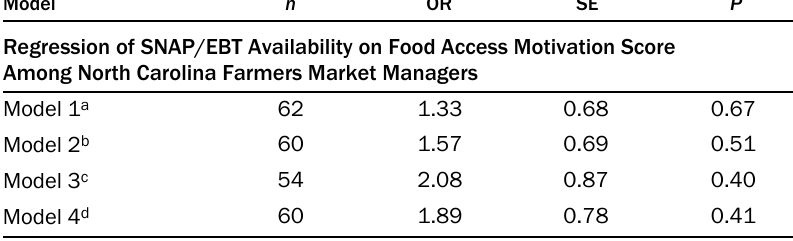
Table 3. Association Between North Carolina Farmers Market Managers’ Food Access and Business Motivation Scores and Supplemental Nutrition Assistance Program Electronic Benefit Transfer (SNAP/EBT) Availability and Business Vitality ( n ranges from 54 to 66, depending on the